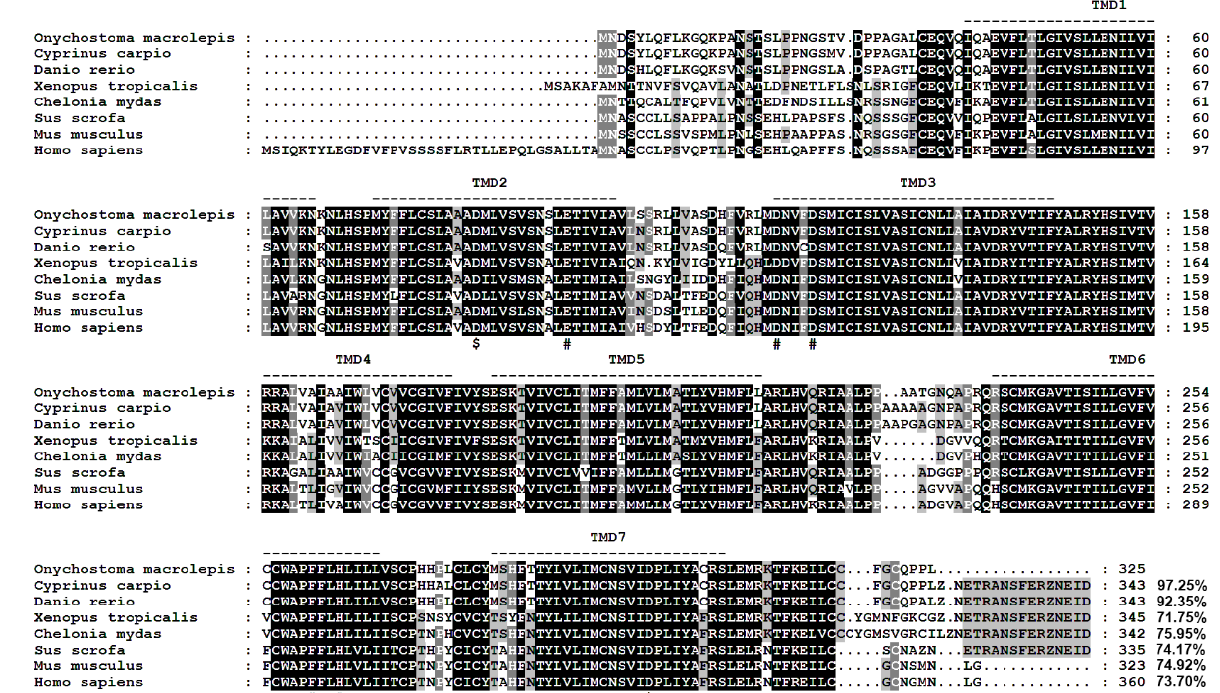
Figure 2. Multiple amino acid sequence alignments of MC3Rs between O. macrolepis and other species. Dashed lines represent the transmembrane domains. $ indicates amino acid residues important for ligand selection. # denotes amino acid residues crucial for ligand binding and signaling transduction.